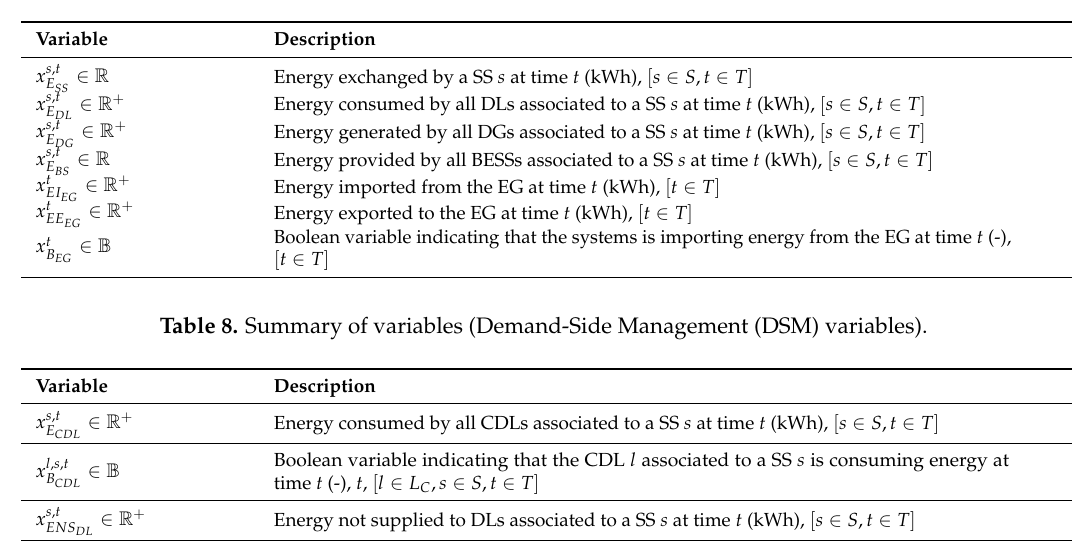
Table 7. Summary of variables (secondary substations (SS) and EG variables).